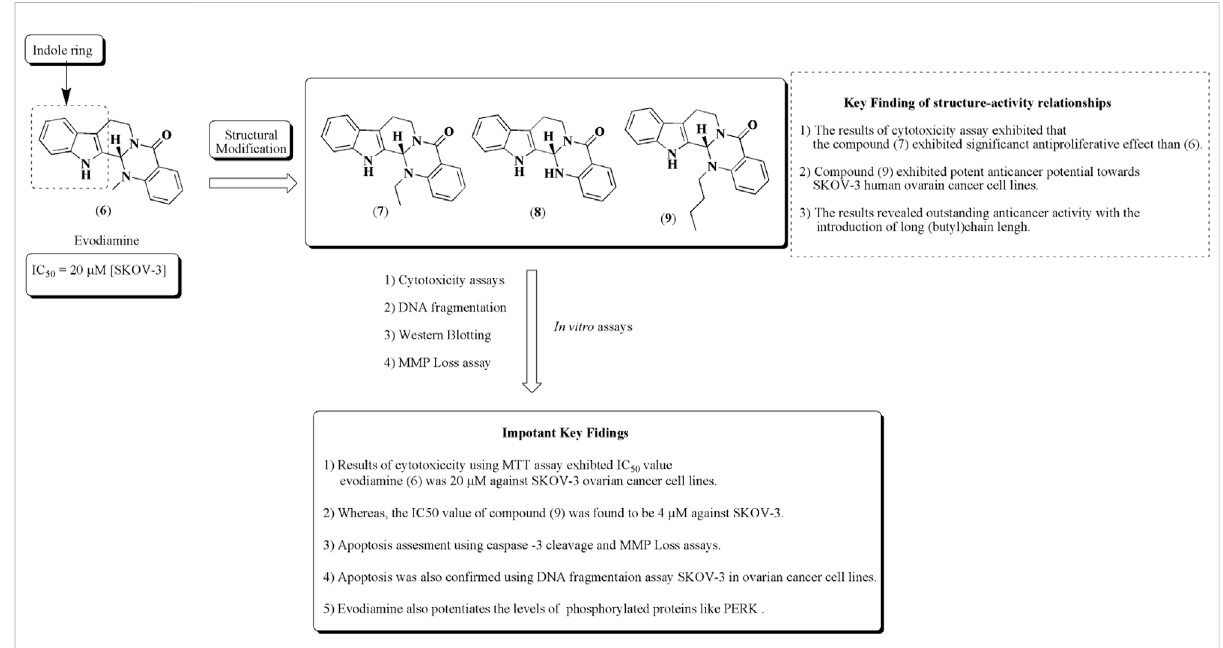
FIGURE 11 Structure of evodiamine along with structure – activity relationships. Anti-ovarian cancer potential of evodiamine was assessed by cytotoxicity assay, DNA fragmentation, Western blotting, and MMP loss assay. The structural analogs of evodiamine are 7, 8, and 9.